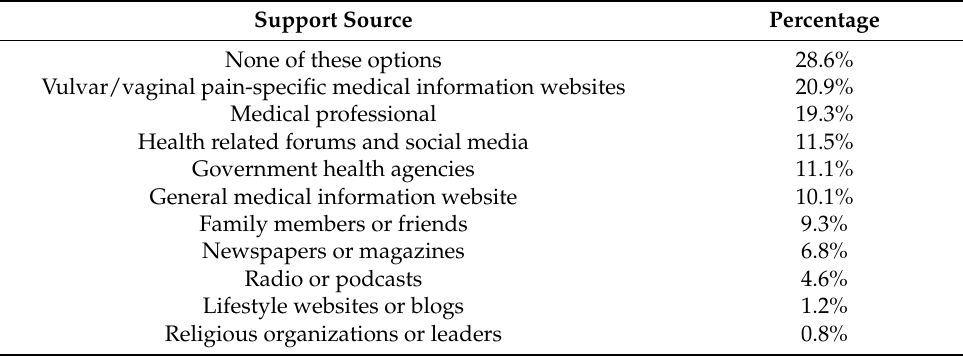
Table 2. Percentages for least helpful emotional support